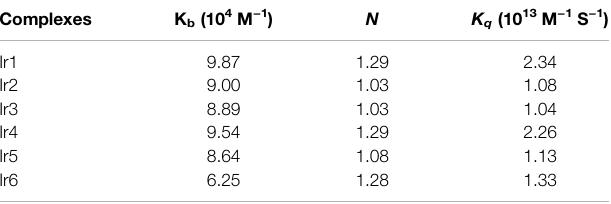
TABLE 2 | Values of K b , K q and n for complexes Ir1-Ir6 at 310